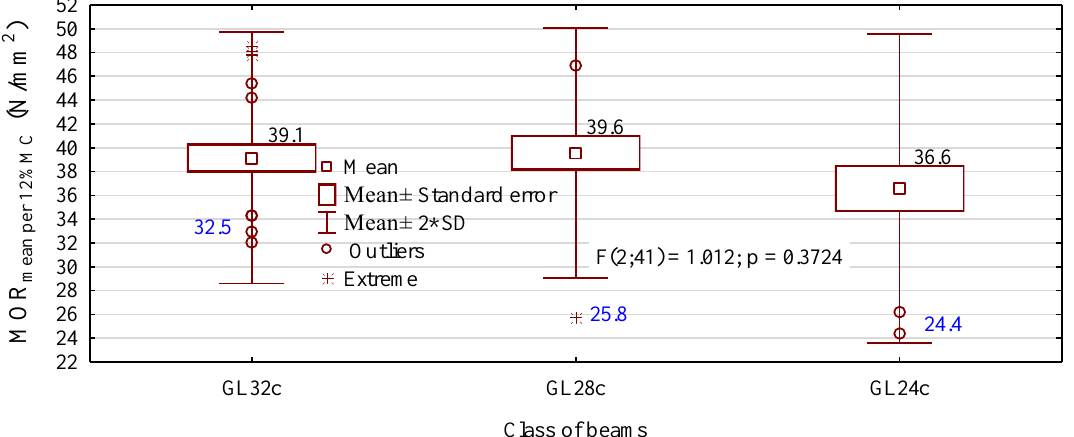
Figure 6. Characteristic values of the static bending strength for the prepared beam (samples). The numbers in blue denote the 5-percentile value.